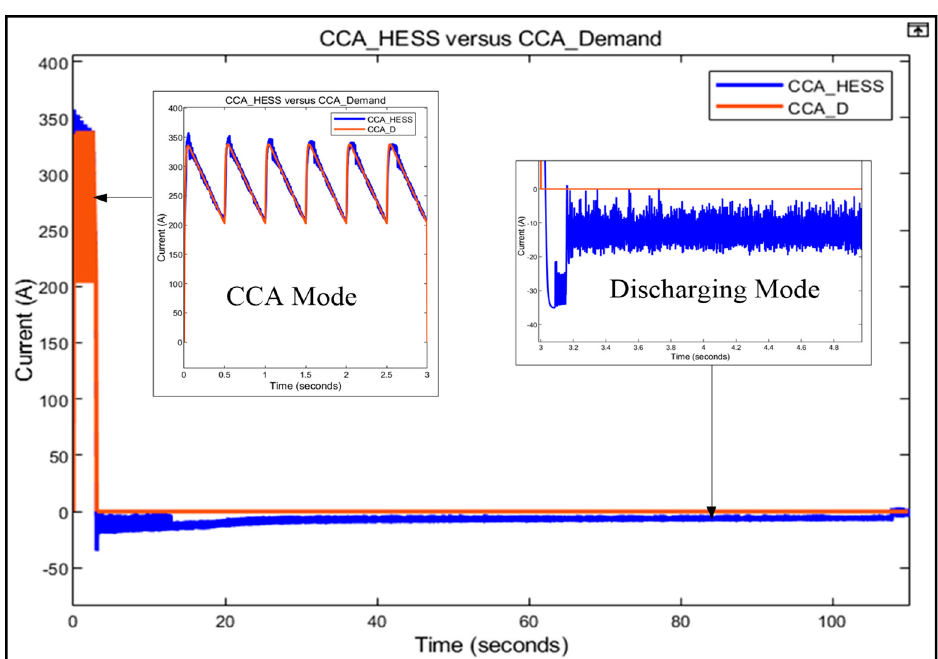
Figure 14. Simulation results of the proposed HESS.